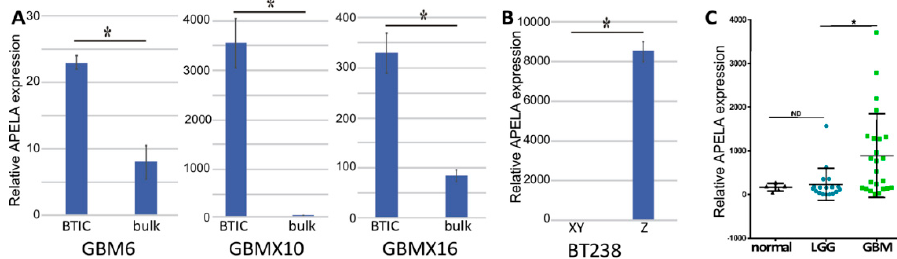
Figure 1. APELA gene expression in brain tumor-initiating cells (BTICs), and in normal brain and glioma samples. ( A ) APELA expression was determined by qPCR in RNA extracts from glioblastoma (GBM) patient-derived xenolines (PDXs) grown in bulk cultures or as BTICs, and ( B ) BTICs isolated from different regions of the BT238 tumor sample (n = 4). ( C ) RNA was extracted from FFPE blocks of normal brain tissue (5 samples), (LGG) low-grade glioma (18 samples) and (GBM) glioblastoma (24 samples), and APELA expression was measured by qPCR and normalized to ACTIN expression. * p <